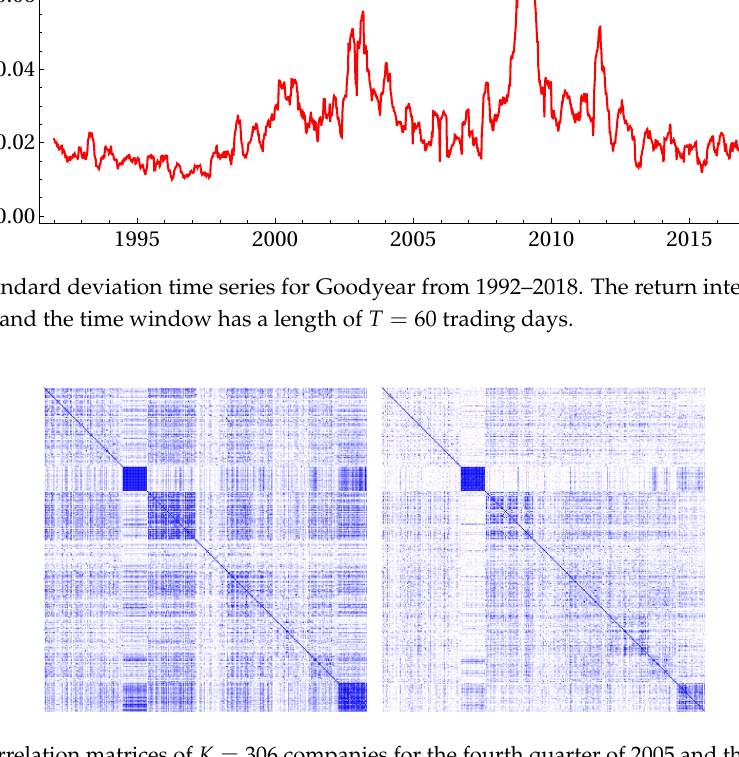
Figure 2. Correlation matrices of K = 306 companies for the fourth quarter of 2005 and the first quarter of 2006; the darker, the stronger the correlation. The companies are sorted according to industrial sectors. Reproduced with permission from (Schmitt et al. 2013),